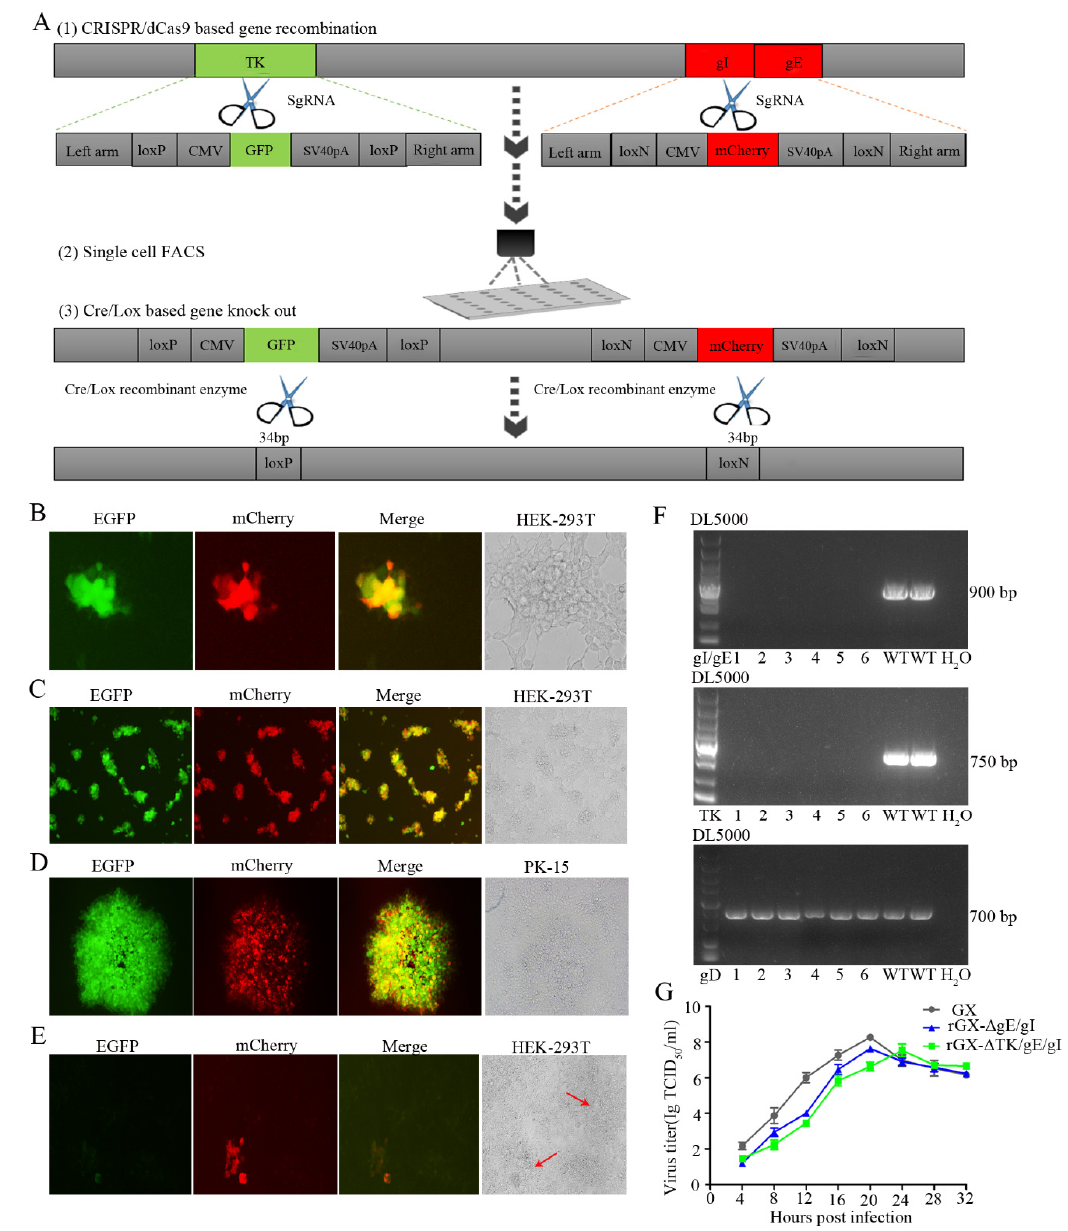
Figure 2. The gE/gI/TK-gene-deleted recombinant PRV (rGX Δ TK/gE/gI) was developed using CRISPR/Cas9 and Cre/Lox systems. ( A ) Overview of the strategy for vaccine development. PRV virulent gene TK and gE/gI were replaced with GFP and mCherry respectively via CRISPR/Cas9 system-assisted homologous recombination. Recombinant virus purification was accelerated using single-cell FACS. The GFP and mCherry gene were deleted through the Cre/Lox system. ( B ) Fluorescence detection was conducted while HEK293T cells were co-transfected with pX335-Cas9-sgRNA-TK, pX335-Cas9-sgRNA-gE, pX335-Cas9-sgRNA-gI, TKhm1-loxP-CMV-GFP-SV40polyA-loxP-TKhm2, and gIhm-loxN-CMV-mCherry-SV40polyA-loxN-gEhm donor templates, PRV genome. Scale bar, 100 μ m. ( C ) Single cells with fluorescent gene recombinant PRV were sorted through FACS. Scale bar, 100 μ m. ( D ) Plaque purification of gE/gI/TK-gene-deleted recombinant PRV in agarose-DMEM plates. Scale bar, 100 μ m. ( E ) Plaque purification for fluorescent genes excision PRV following Cre–recombinase treatment. Arrows indicate cell plaques. Scale bar, 100 μ m. ( F ) PCR verification of TK and gE/gI gene deletion. ( G ) One-step growth curves of the recombinant viruses in BHK-21 cells.